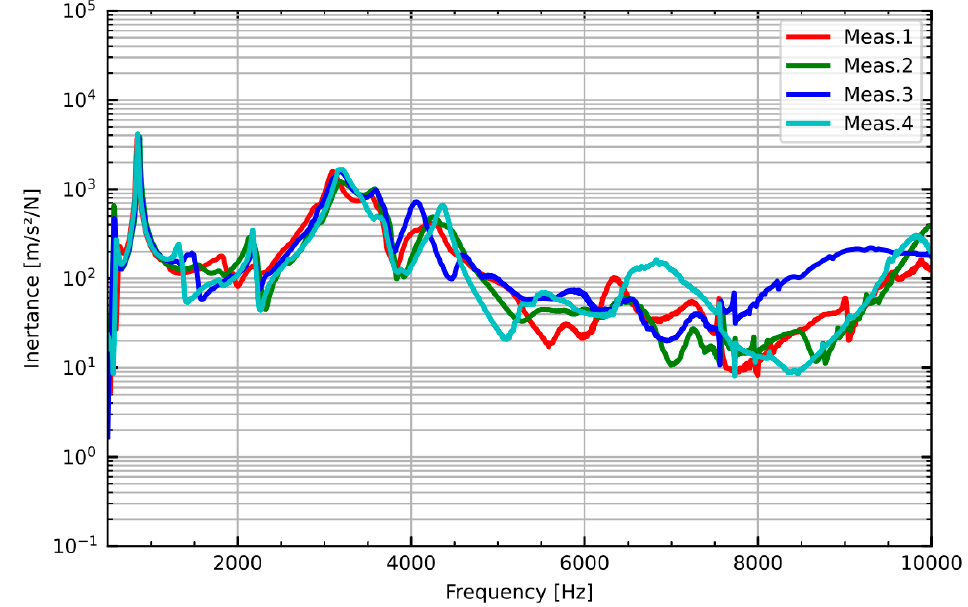
Figure 3. Repeatability of the “pouring filling”; repeated four times with the usage of water.